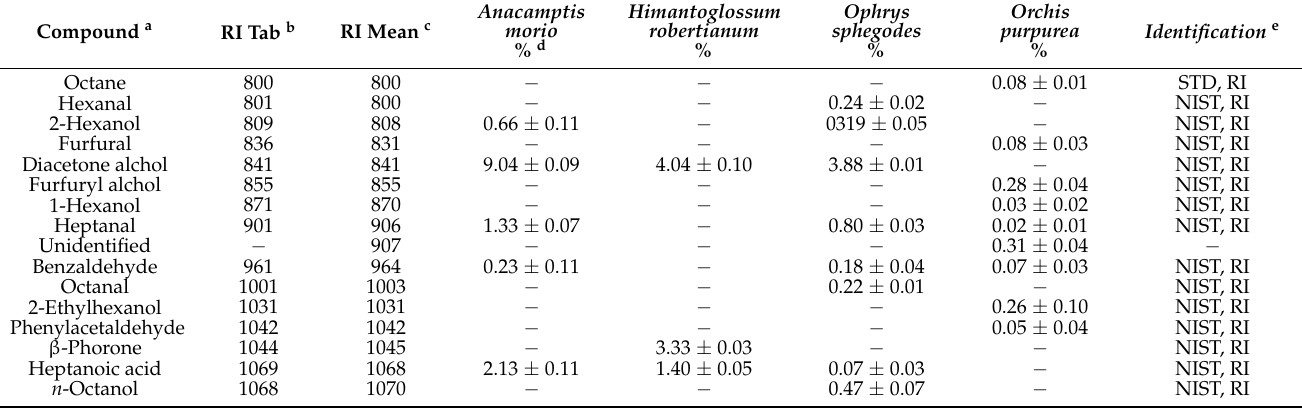
Table 1. List of compounds identified in the essential oils obtained from inflorescences of A. morio , H. robertianum, O. sphegodes and O. purpurea